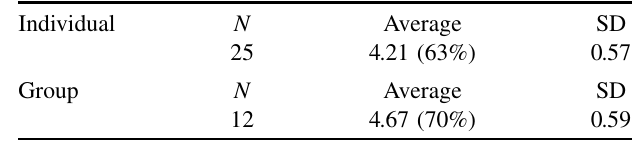
TABLE II. Number of graduate students and groups, averages (and percentage of those averages out of the maximum PCK score), and standard deviations for the PCK scores obtained for identifying the most common introductory student difficulties on the TUG-K out of a maximum PCK score of